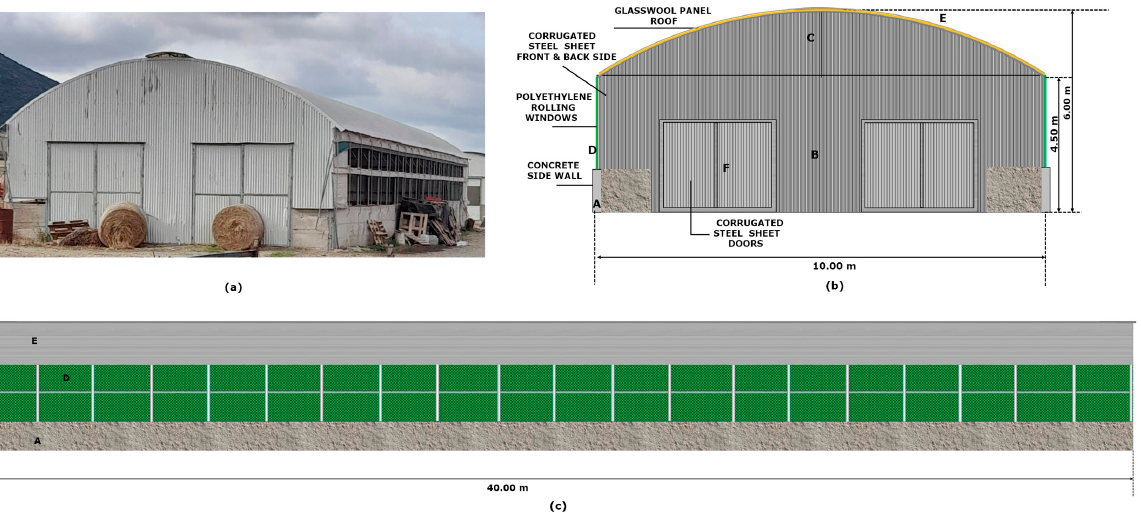
Figure 1. (a) Outside view of the sheep barn near Galatista town; schematic views with dimensions of ( b ) the front and ( c ) the side of the building. Table 1. Sheep barn material properties, geometrical characteristics and the U value [33 – 38 ] .